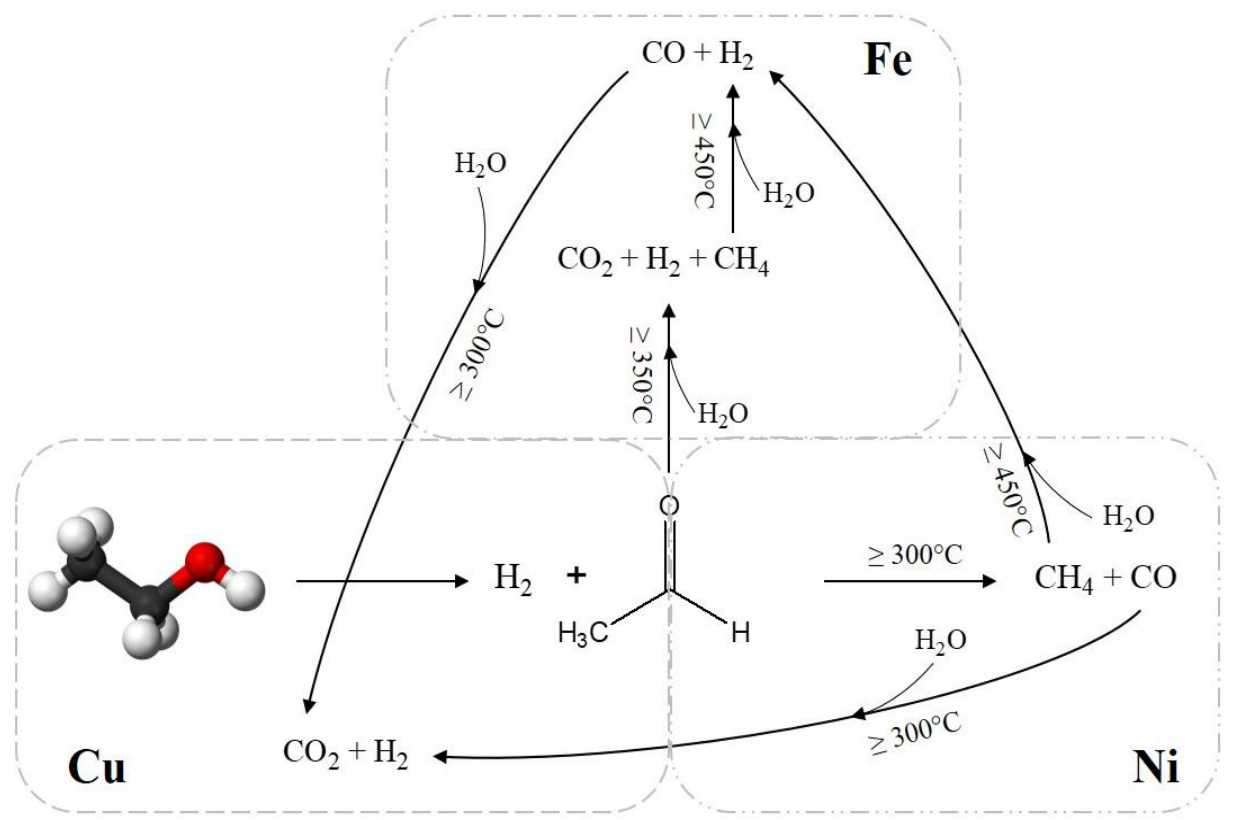
Figure 5. Schematic reaction pathway of the ESR reaction over the Cu/Fe/Ni_BEA system (adapted from [72]).